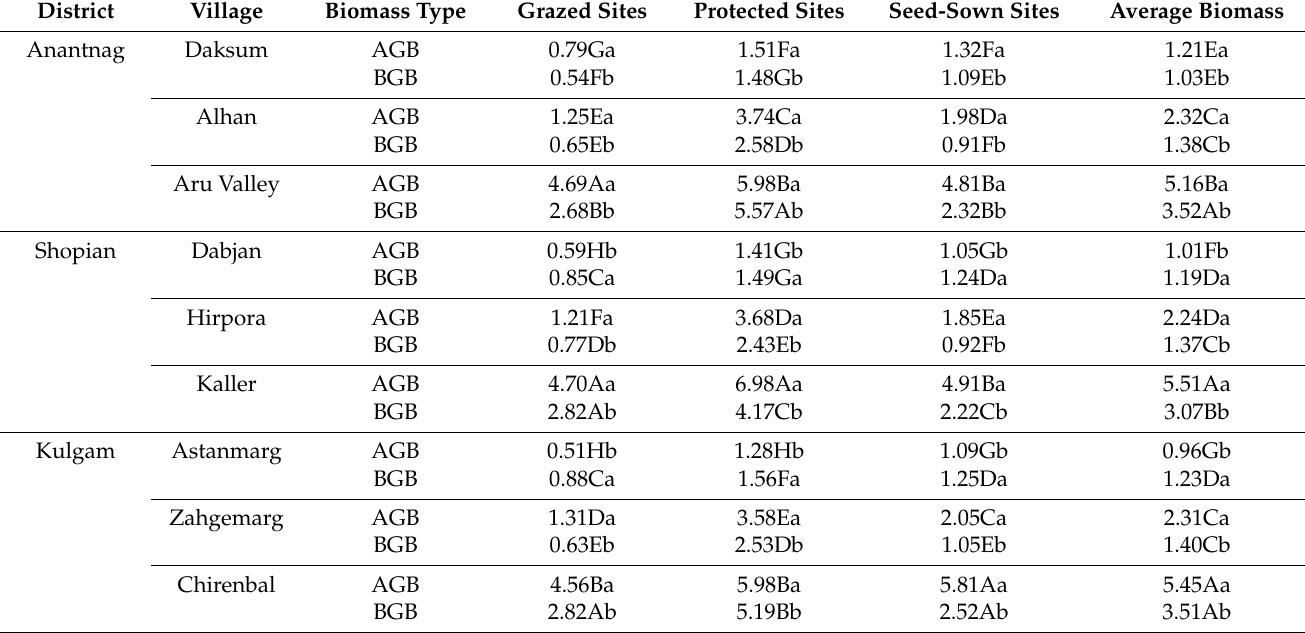
Values are means (3 replicates of each biomass type); means within the same column (comparison between villages in terms of AGB/BGB) followed by different capital letters are significantly different at p < 0.05 according to Duncan test; means within the same column (comparison between AGB and BGB within each village) followed by different lowercase letters are significantly different at p < 0.05 according to the Student’s t test. 2.4. Comparison of Above (AGB), Belowground Biomass (BGB) and Total Biomass Yield between Kashmir Regions The comparison between northern, central, and southern Kashmir regions revealed that AGB (86.74, 78.62, and 75.22 t. ha − 1 ), BGB (52.04, 51.16, and 50.99 t. ha − 1 ), and total biomass yield (138.78, 129.78, and 126.21 t. ha − 1 ) were the highest in central Kashmir region, followed by southern and northern Kashmir ones, respectively, (Figure 1). More precisely, AGB and total biomass yield recorded the highest values in the protected sites of central Kashmir region (42.04 and 68.41 t. ha − 1 , respectively), whereas BGB scored the highest value in the protected sites of southern Kashmir region (27.00 t. ha − 1